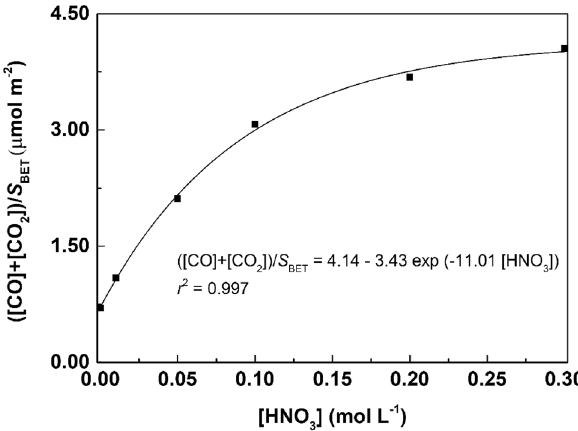
Figure 5. ([CO 2 ] + [CO])/ S BET as a function of HNO 3